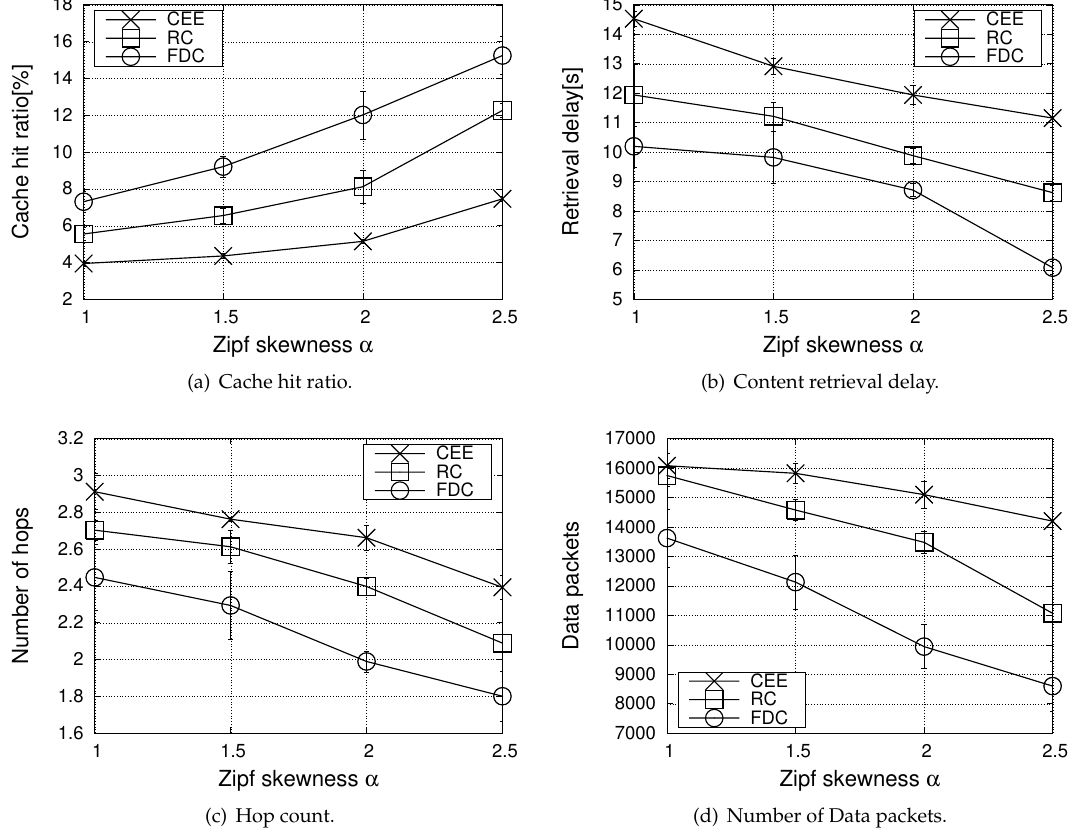
Figure 6. Performance metrics in the highway scenario, when varying the Zipf skewness parameter α (number of consumers equal to